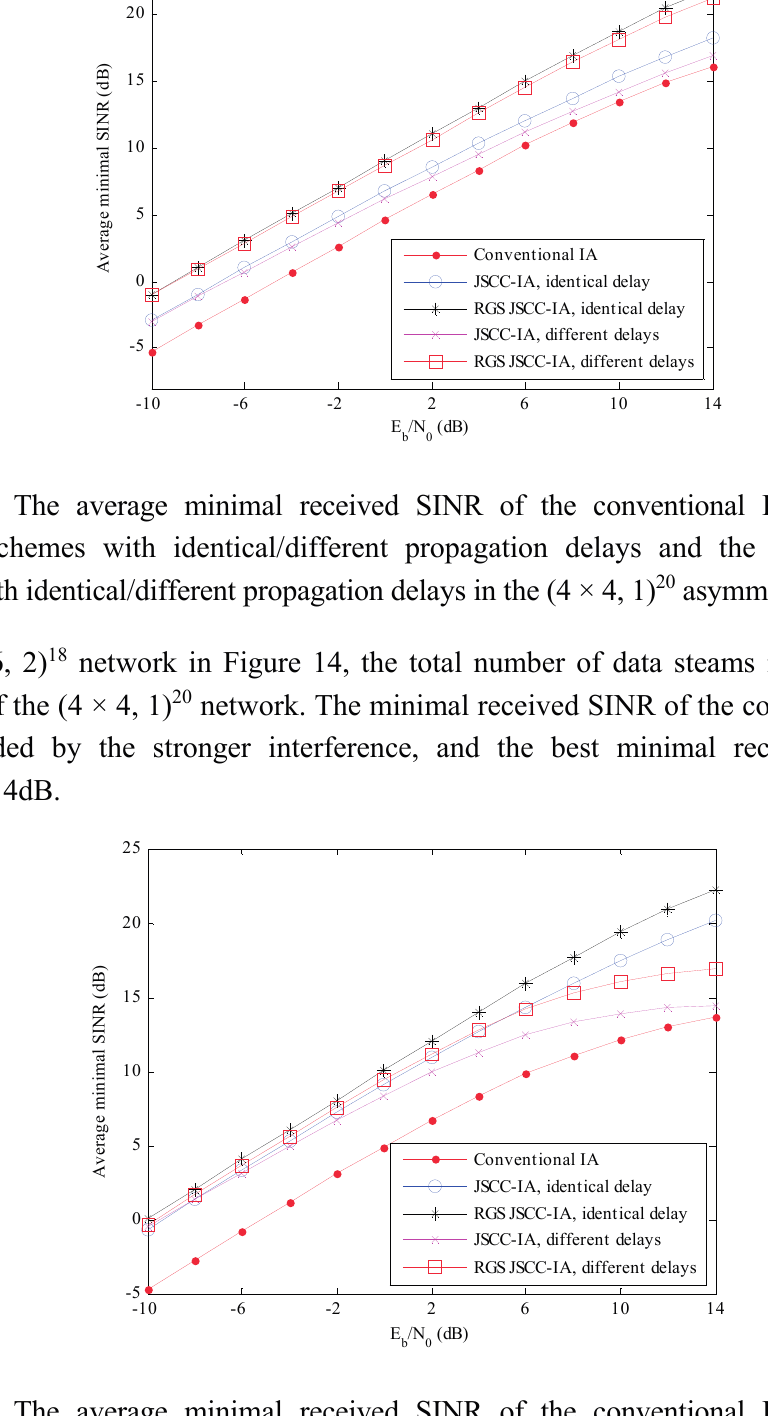
Figure 14. The average minimal received SINR of the conventional IA scheme, the JSCC-IA schemes with identical/different propagation delays and the RGS JSCC-IA schemes with identical/different propagation delays in the (6 × 6, 2) 18 asymmetric